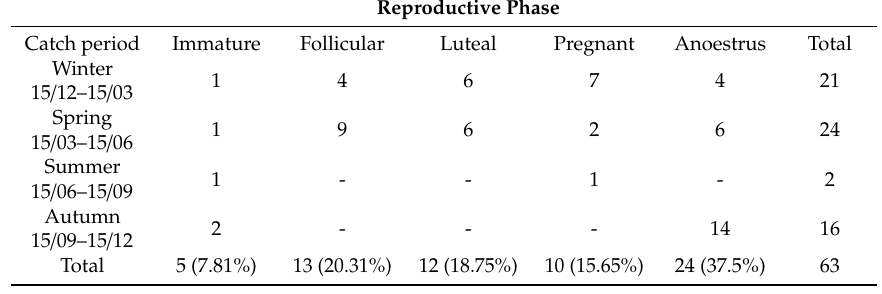
Table 2. Seasonal distribution of female squirrels according to their reproductive phases.